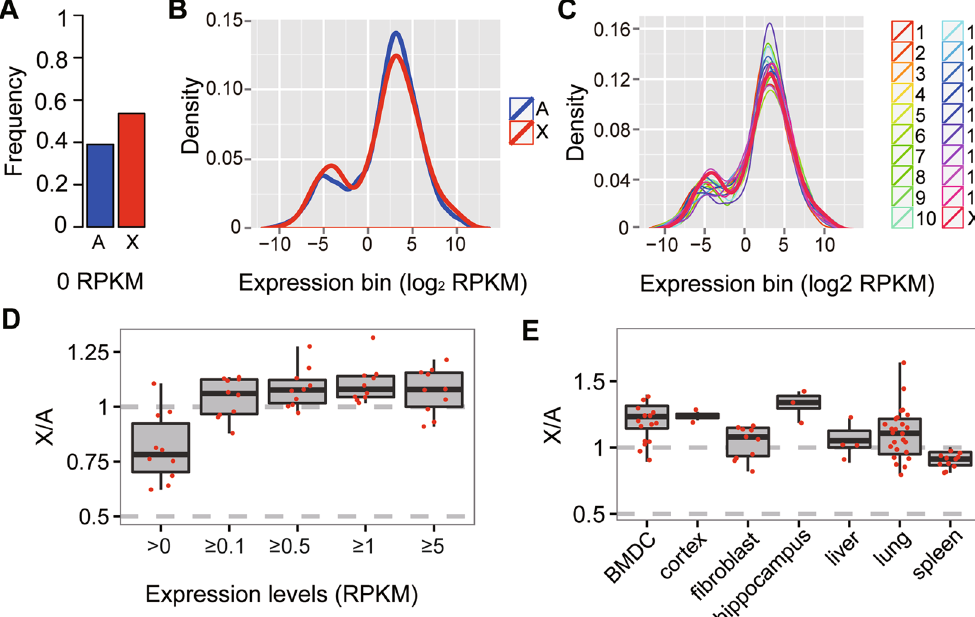
Figure 3. Distributions of gene expression are similar between the X chromosome and autosome in mammals at the single cell level. ( A ) The frequency of genes with no expression was significantly higher on the X chromosome than on autosomes in mouse fibroblast cell based on single cell RNA-Seq(P < 0.05, by Student’s t-test). ( B ) Histograms of X-linked and autosomal expression distributions (P > 0.05, by Kolmogorov- Smirnov test). ( C ) Histograms of expression distribution for genes with > 0 FPKM on each mouse fibroblast chromosome expect (P > 0.05, by Kolmogorov-Smirnov test). ( D ) X: A median expression ratios based on single cell RNA-Seq data were strongly dependent on FPKM cutoffs ( > 0, ≥ 0.1, ≥ 0.5, ≥ 1, ≥ 5). There were no differences between each ≥ 0.1expression threshold. (P > 0.05, by Student’s t-test). ( E ) X: A ratios of median expressions based on single cell RNA-Seq from bone marrow-derived dendritic cells (BMDC) (male, N = 15), cortex cells (N = 2), fibroblast cells (female, N = 10), hippocampus cells (N = 3), liver cells (female, N = 4), lung cells (N = 25) and spleen cells (male, N = 10) when excluding no-/low-expression genes. Sex information is listed in parentheses after the cell names, and N represents the number of single cell RNA-seq data with this type of cells in the parentheses after the cell names. There were no differences between each types of single cells. (P > 0.05, by student’s t-test) except cortex and hippocampus (P < 0.05, by Student’s t-test). And the X: A ratio is significant closer to 1 compared to 0.5 (Student’s t-test, p < 0.001). The percentiles in all boxplots are 0.05, 0.25, 0.5, 0.75 and